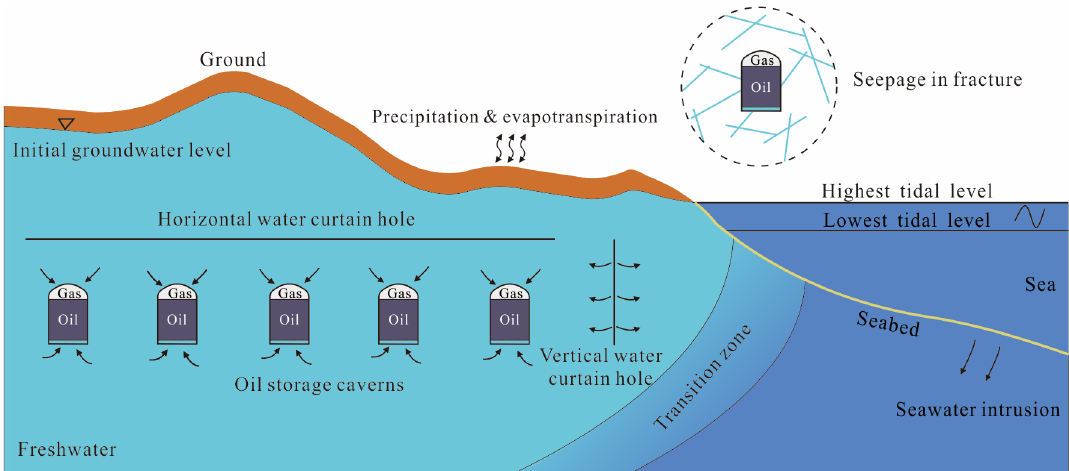
Figure 1. Model diagram of an underground water-sealed oil storage cavern.